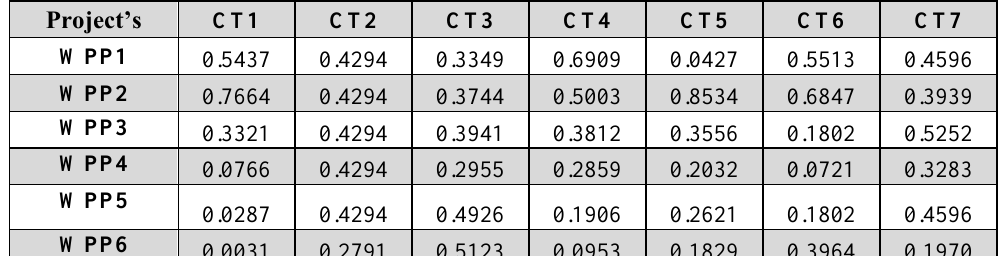
Table 9. Normalized matrix